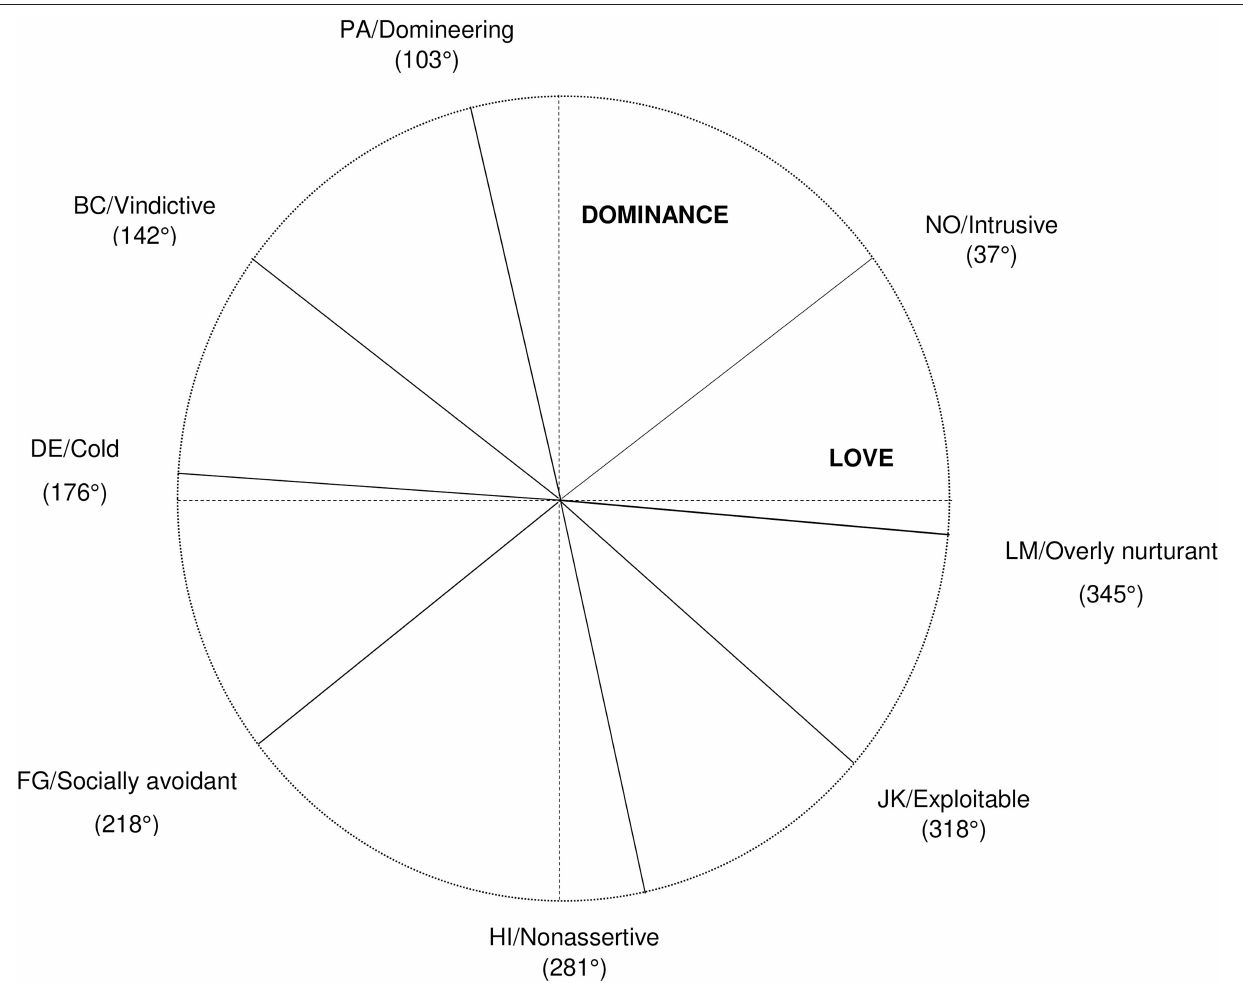
FIGURE 3 | Circumplex structure of the inventory of interpersonal problems modeled by Bayesian confirmatory factor analysis. Circumplex angles with relation to the Dominance and Love factor were obtained by applying trigonometric functions to posterior loadings from Bayesian confirmatory factor analysis. The radius of the scales was kept at one by Kaiser-normalizing all loadings prior to trigonometric transformation. The dashed lines represent the Dominance and Love factor, the solid lines represent the scales from the inventory of interpersonal